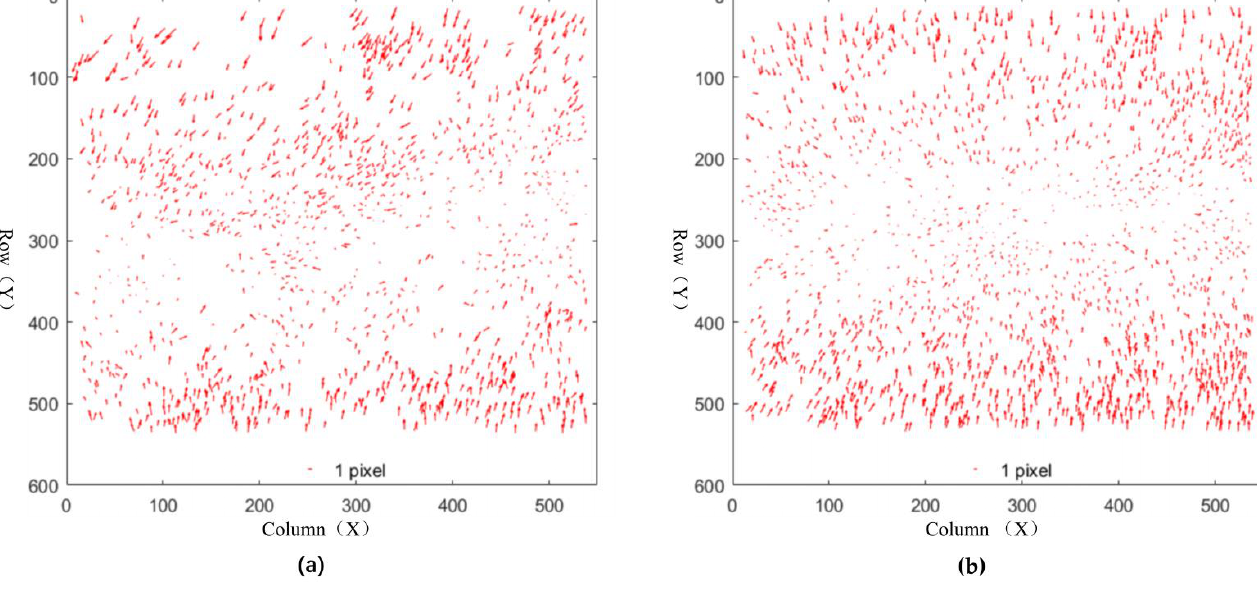
Figure 4. Residuals after external calibration of laser footprint cameras (LFCs). ( a ) Residual after external calibration of LFC1. ( b ) Residuals after external calibration of LFC2. Table 2. Residuals after external calibration of laser footprint cameras (LFCs).